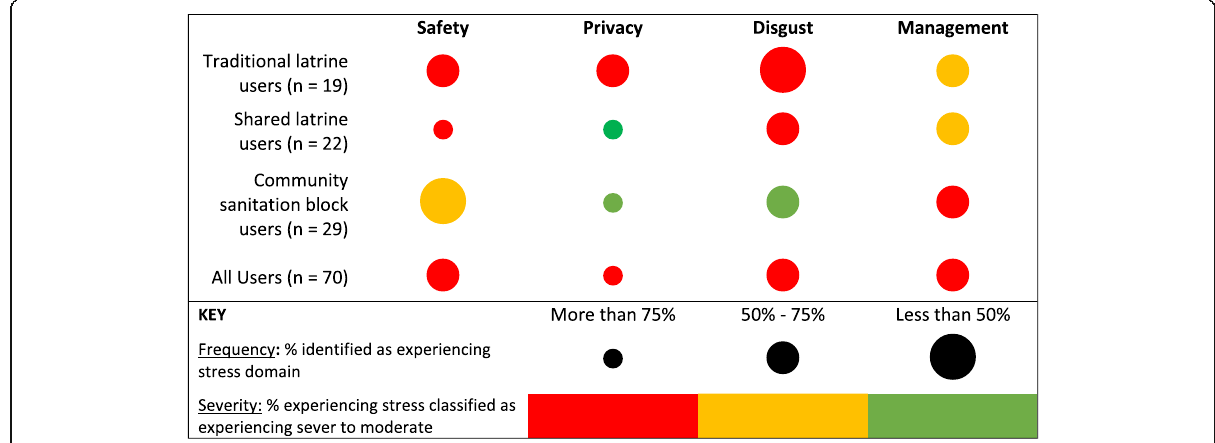
Fig. 1 Frequency and severity of specific sanitation-related stress domains as identified in in-depth interviews with adult female respondents of shared sanitation in peri-urban Maputo,